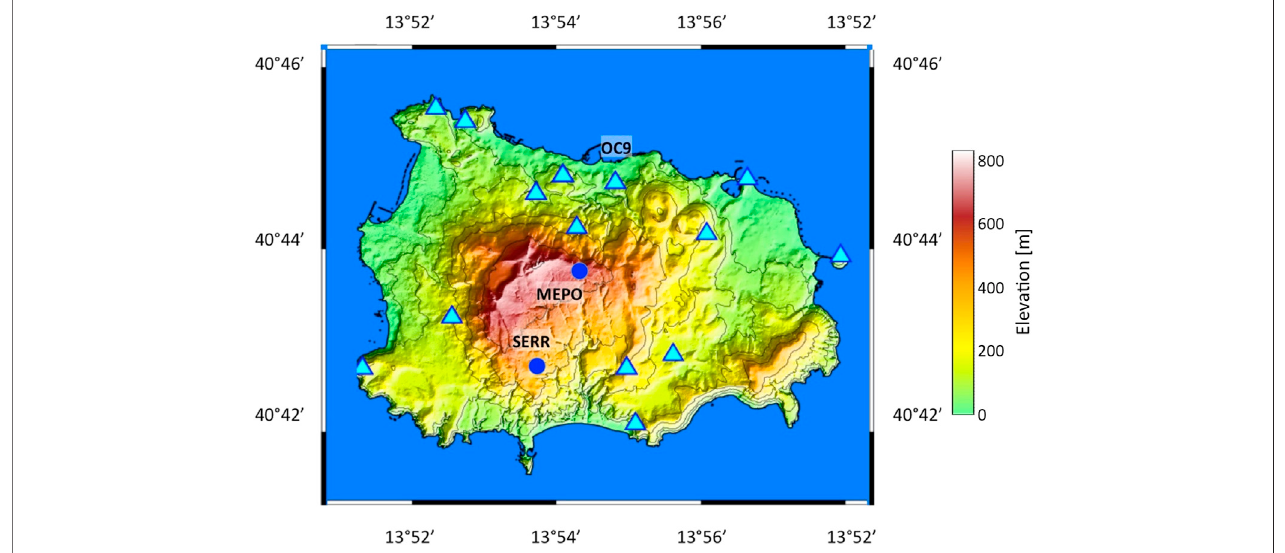
FIGURE 4 | Map of Ischia island with the seismic stations (cyan triangles) and the two GPS, stations MEPO and SERR (blue circles) that were considered in this work. OC9 is the reference station for the seismic catalog of Ischia.